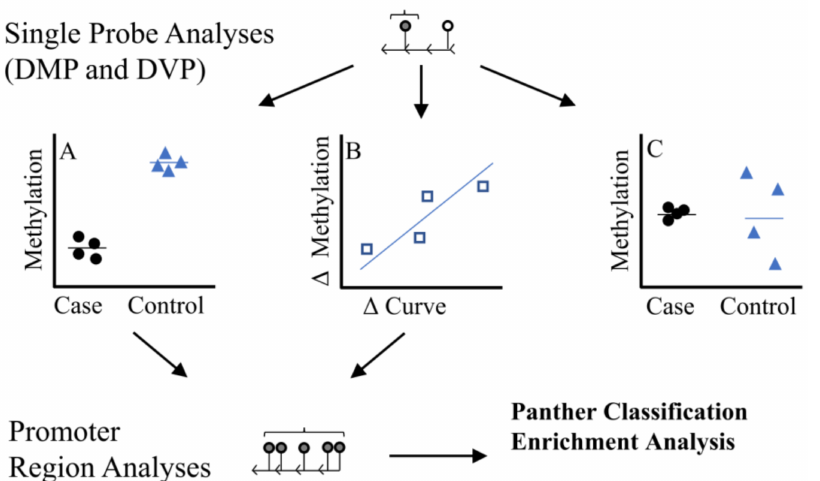
Figure 1. Study Methodologic Workflow. Differentially methylated position (DMP) analyses were used to identify single probes. We used two DMP strategies (1) Discordant DMP Analysis ( A ), differences in methylation between cases (twin with more severe IS) relative to controls (twin with less sever IS) (2) Severity DMP Analysis ( B ) looked at association between difference in curve severity and methylation ∆ curve vs ∆ methylation , where ∆ methylation = methylation levels in affected/more severe twin–methylation levels unaffected/less severe twin and ∆ curve = primary curve magnitude in affected/more severe twin–primary curve magnitude is unaffected/less severe twin. We also looked at differences in variability at single probes (differentially variable position analysis, DVP) among cases compared to controls ( C ). Region analyses based on single probes from ( A , B ) were used to identify regions of consistent methylation effects within promoter regions. We only considered regions with 5 or more probes where direction of effect was consistent across all probes. DVP probes ( C ) were not considered in the region analysis due to challenges interpreting a ‘consistent’ direction of effect based on